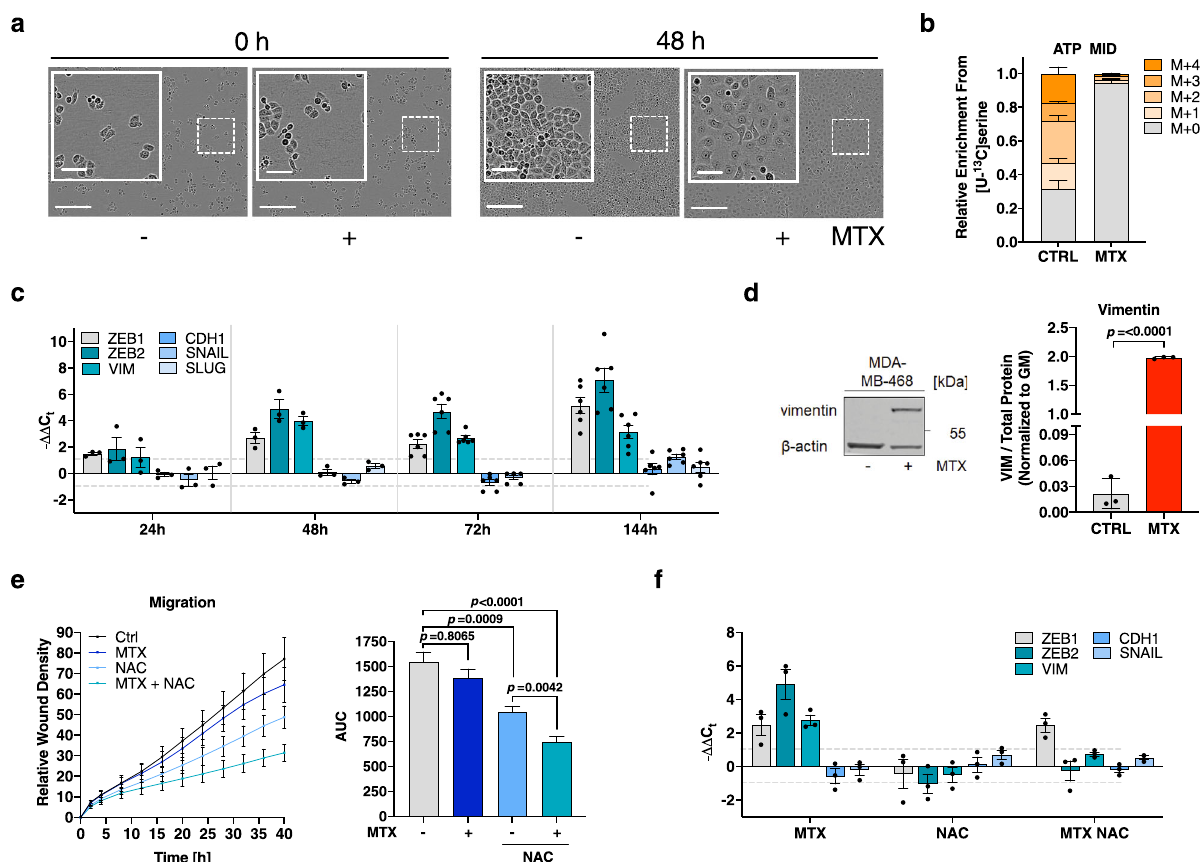
Fig. 2 Enhanced motility under MTX is supported by a ROS-driven EMT phenotype. a Morphology of MDA-MB-468 cells after 48 h 50 nM MTX. Bright- fi eld images are representative of 3 independent experiments. Scale bars correspond to 60 and 300 μ m. b Mass isotopomere distribution (MID)